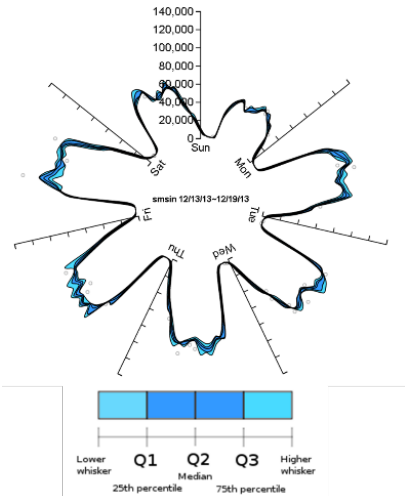
raster map per day for each variable).